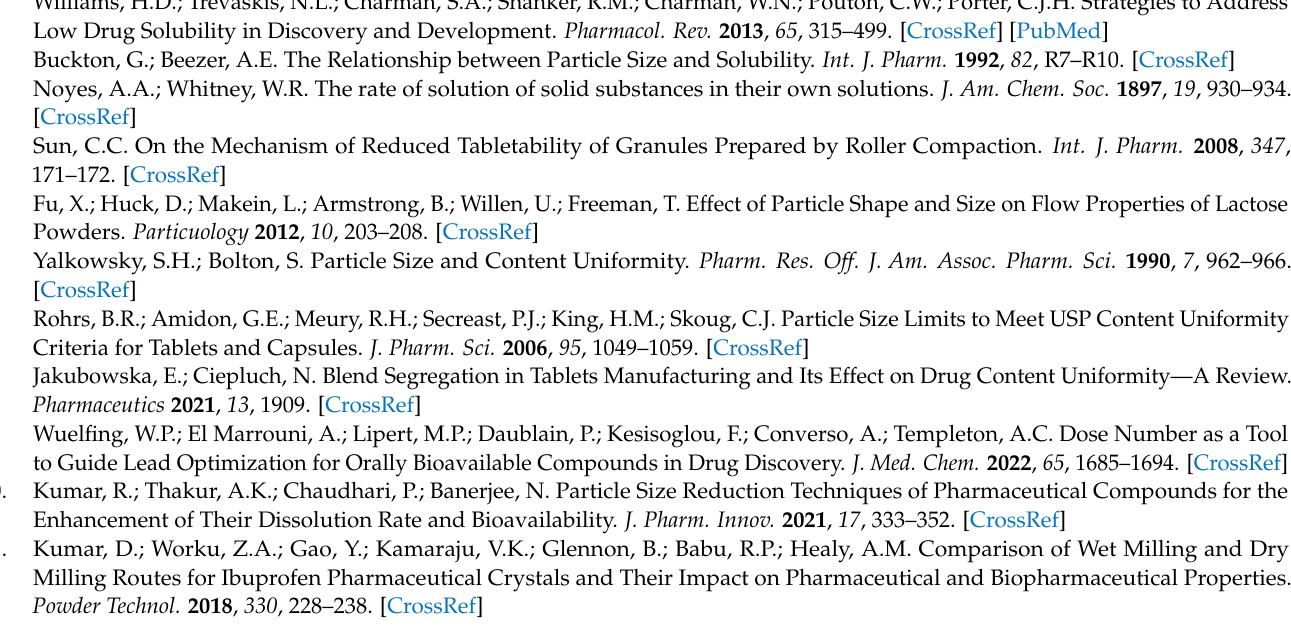
Figure 7a). Figure S3. XRD overlap of Samples A3, A(S) and A(M). (Enlargement of Figure 9a). Table